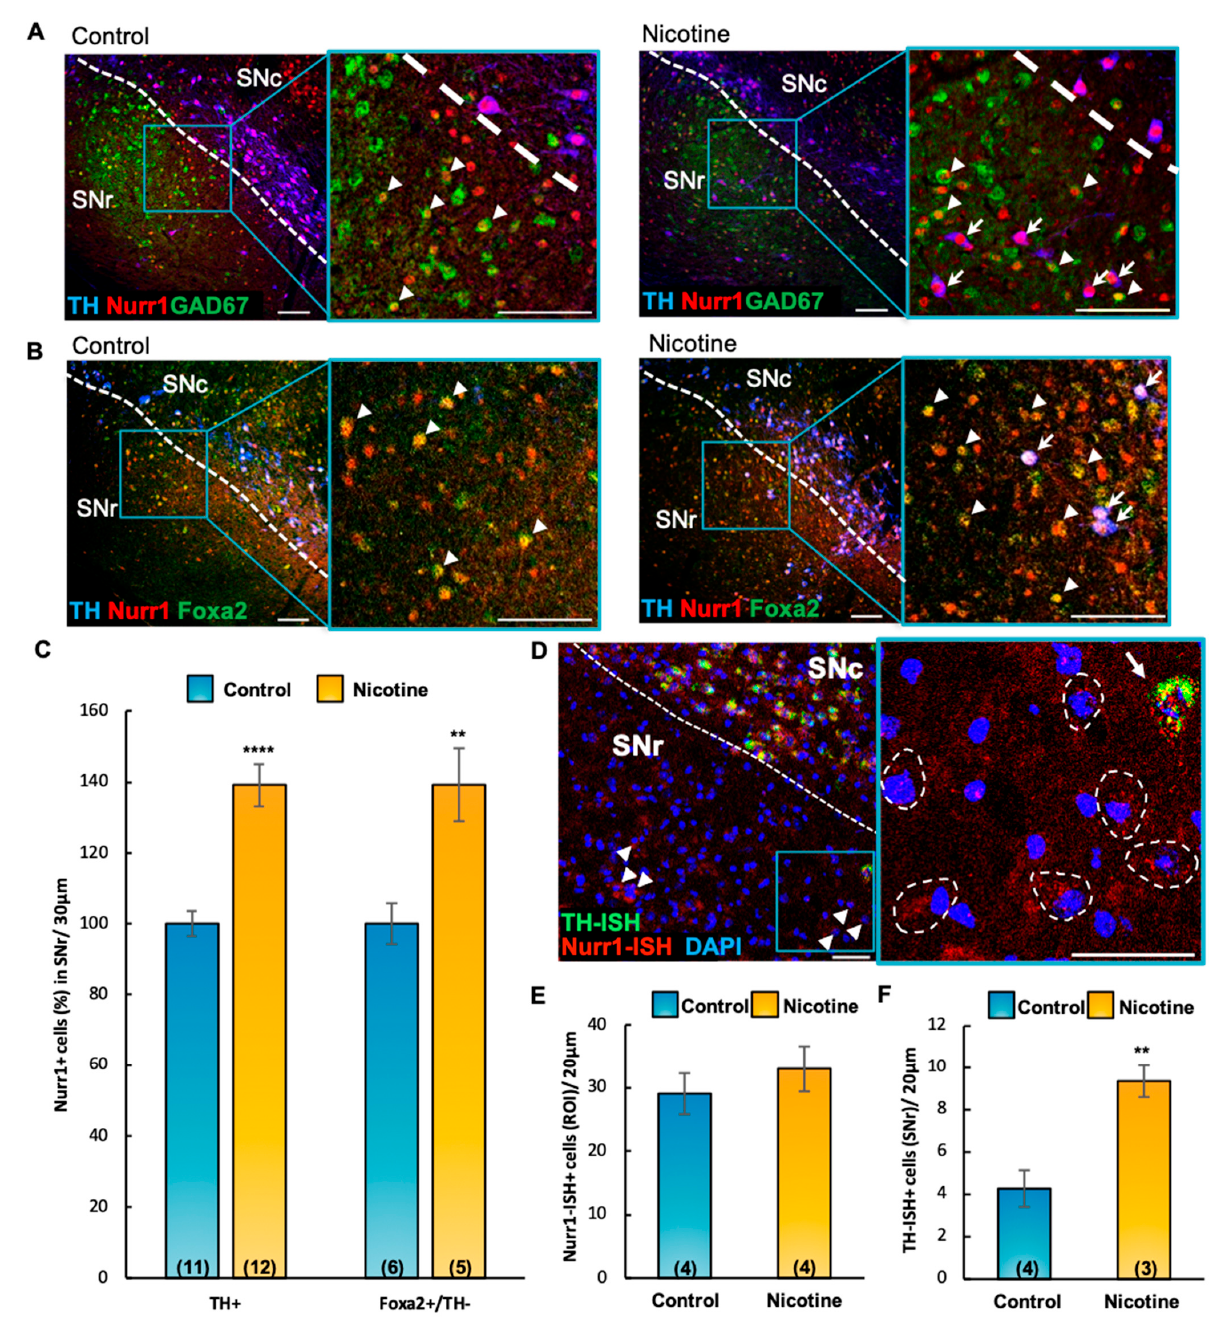
projecting neurons (Figure 6B). RetroBead accumulation was detected in both VGAT+/TH- (Figure 5B, arrows) and TH+ SNr somata (Figure 6B inset, arrowhead), in addition to all TH+ SNc-to-striatum projecting neurons. The fraction of Nurr1+ GABAergic neurons projecting to the striatum could serve as a reserve neuronal pool with the potential to acquire the TH phenotype and in turn replenish DA function in PD.